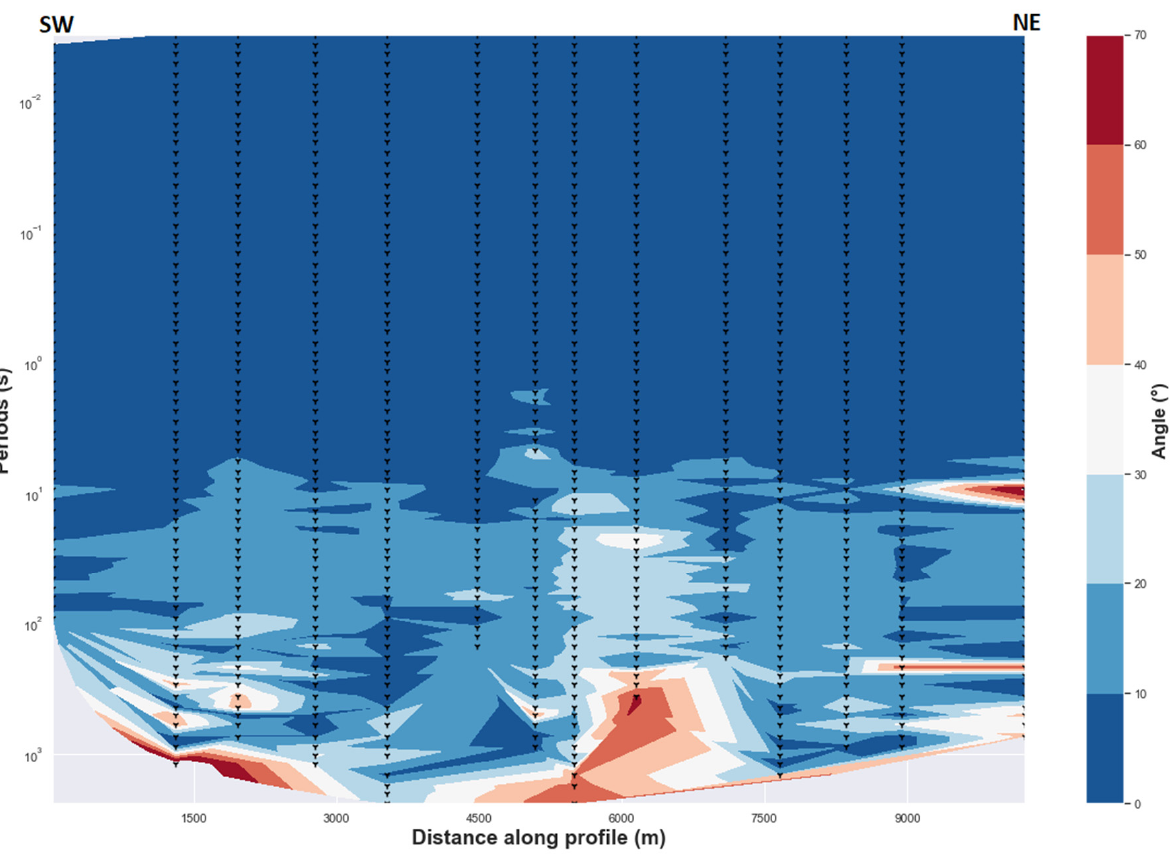
Figure 6. Phase difference between the two orthogonal components (TE and TM) phases. The dashed black triangles indicate the locations of MT stations at various periods. Values of phase difference greater than 10° are considered high. Delaunay triangulation method is used.